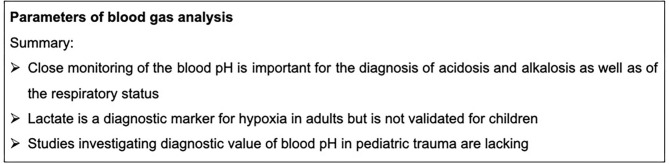
Summary box parameters of blood gas analysis.